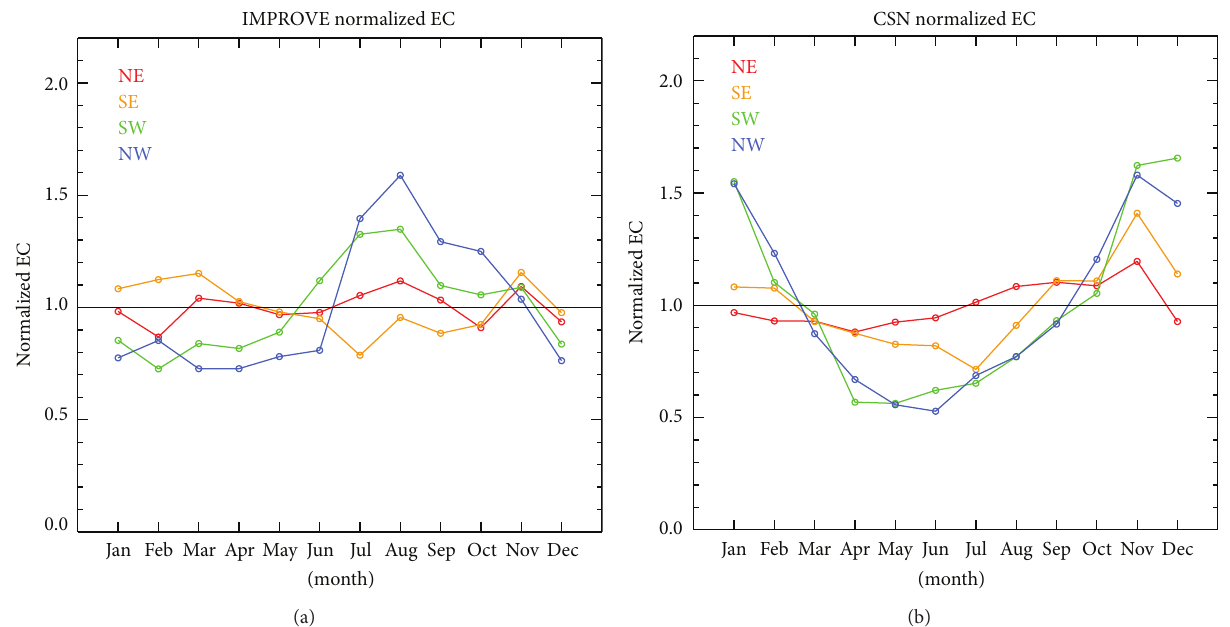
Figure 6: 2007–2010 regional monthly mean normalized (by annual mean) PM 2.5 elemental carbon (EC) for (a) IMPROVE and (b) CSN. Regions correspond to the Northeast (NE), Southeast (SE), Southwest (SW), and Northwest